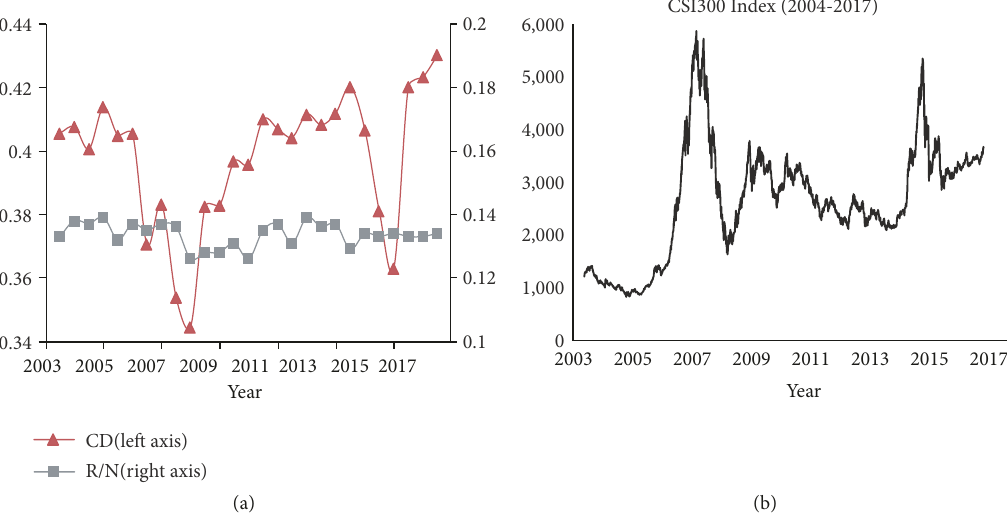
Figure 4: (a) The contrarian degree CD and the proportion of contrarians R/N of China's stockmarket from Jan 2004 to Jun 2017. (b) Closing price of the CSI300 Index from Jan 2004 to Jun